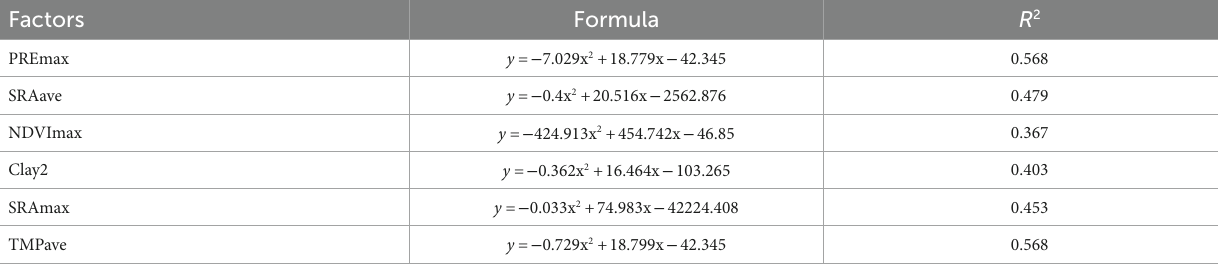
TABLE 4 Fitted models constructed based on PREmax, SRAave, NDVImax, Clay2, SRAmax, and TMPave.